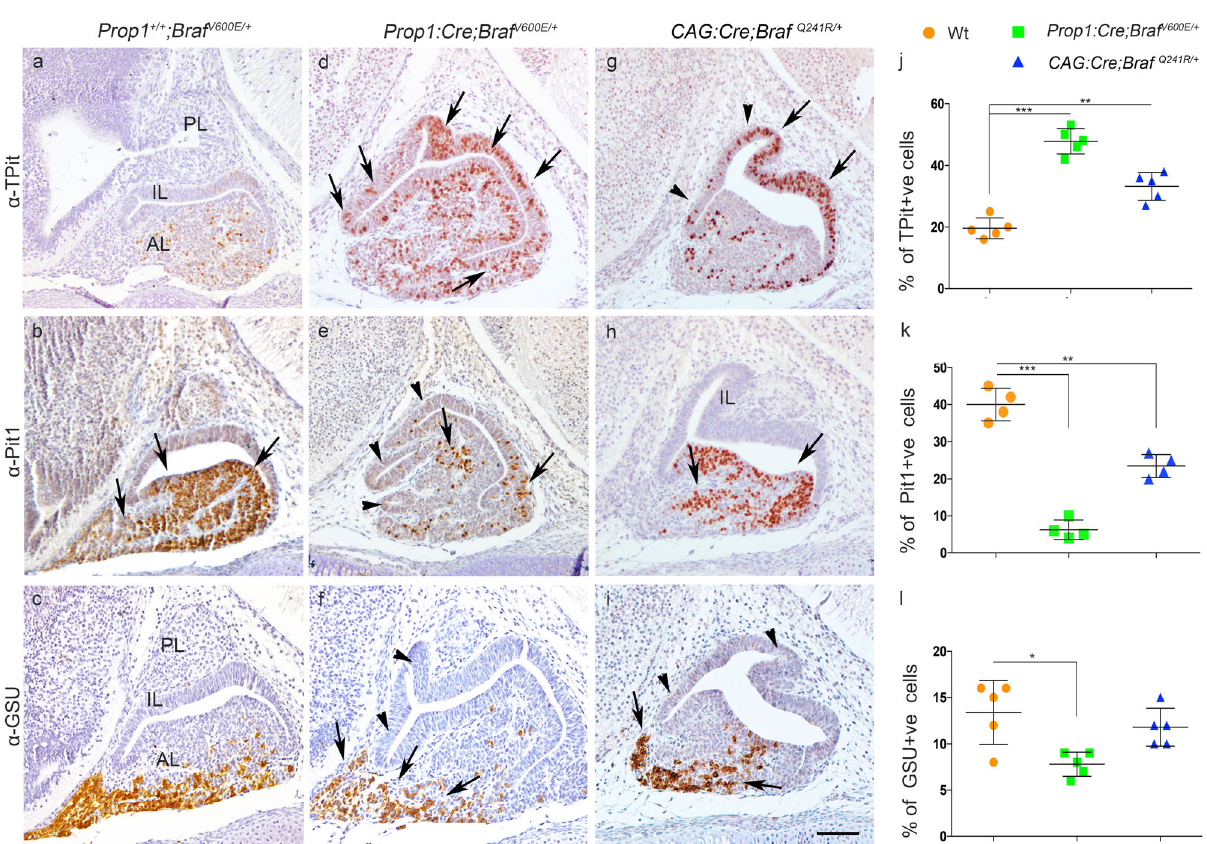
Fig. 7 Expression of Braf V600E and Braf Q241R leads to abnormal cell lineage speci fi cation with increase in TPit (corticotrophs and melanotrophs) and decrease in Pit1 (somatotrops, thyrotrophs and lactotrophs). IHC against TPit ( a , d , g ), Pit1 ( b , e , h ) and α -GSU ( c , f , i ) on sagittal section of E15.5 embryos of Wt ( a – c ), Prop1:Cre;Braf V600E/ + ( d – f ) and CAG:Cre;Braf Q241R/ + ( g – i ). Expression of TPit was increased in the Prop1:Cre;Braf V600E/ + and CAG:Cre;Braf Q241R/ + pituitaries compared to Wt (arrows in d , g ). Quanti fi cation of TPit-positive cells shows statistically signi fi cant increase in the % of TPit + ve cells in both Prop1:Cre;Braf V600E/ + and CAG:Cre;Braf Q241R/ + pituitaries compared to Wt ( j ). Severe reduction of Pit1 immunoreactivity